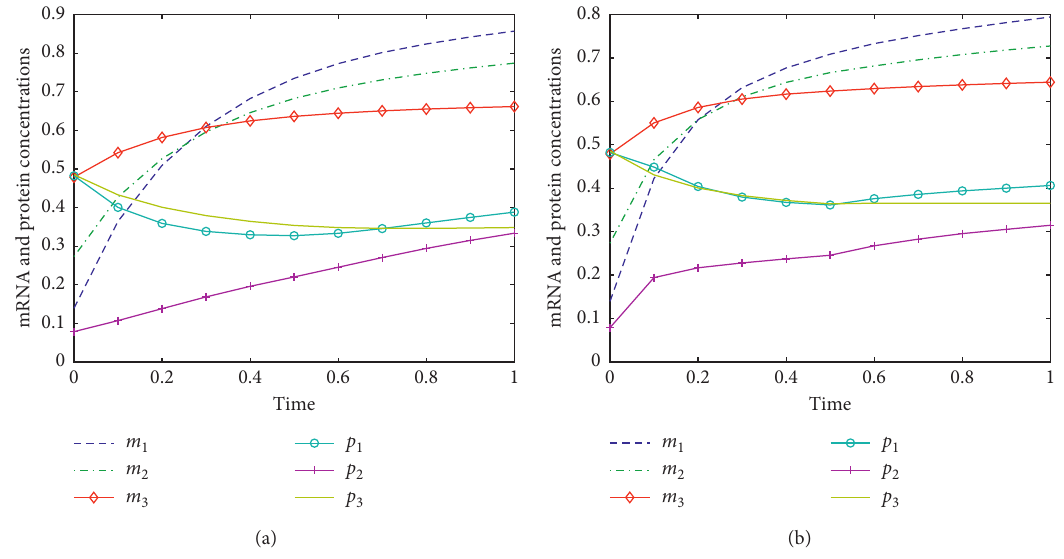
Figure 2: Transient states of DFGRN (62) with (a) q � 0 . 95 and (b) q � 0 . 6.